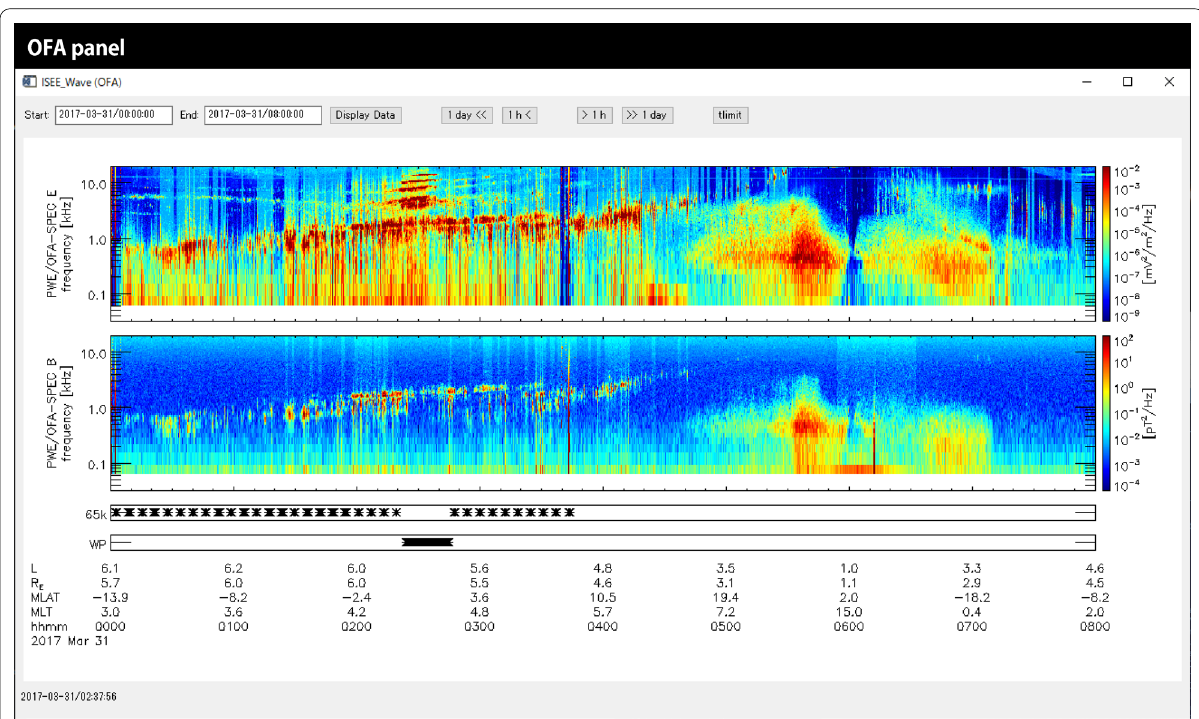
Fig. 2 A snapshot of the OFA panel when the time interval from 00:00:00 to 08:00:00 on 31 March 2017 is